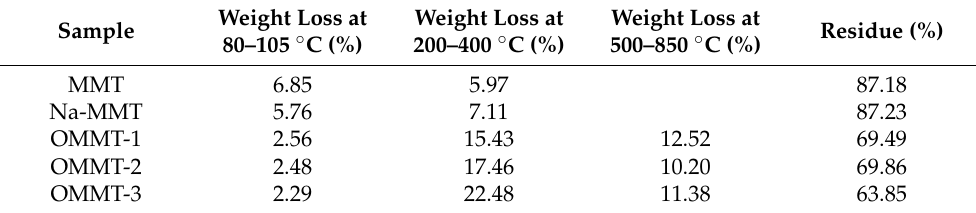
Table 2. Comparison of weight loss between the montmorillonite (MMT) and its products.